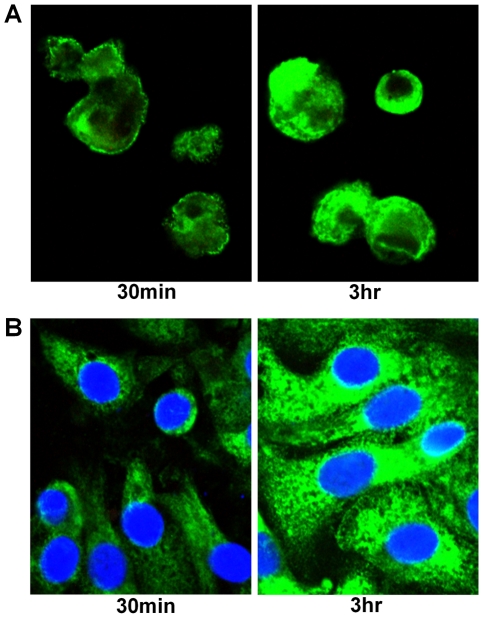
Cellular localisation of TLR4 protein in primary human alveolar macrophages and ATII cells.Under high magnification it can be seen that, in alveolar macrophages (A), there is distinct expression of TLR4 protein at the cell surface at 30 minutes with some intracellular staining. By three hours the intracellular staining has increased greatly (in particular in the perinuclear region). In contrast, in ATII cells there is strong intracellular TLR4 expression at 30 minutes which increases further by 3 hours. Similarly to the alveolar macrophages, intracellular staining is most intense in the perinuclear region. TLR4 expression could not be visualised in ATI cells due to low expression.